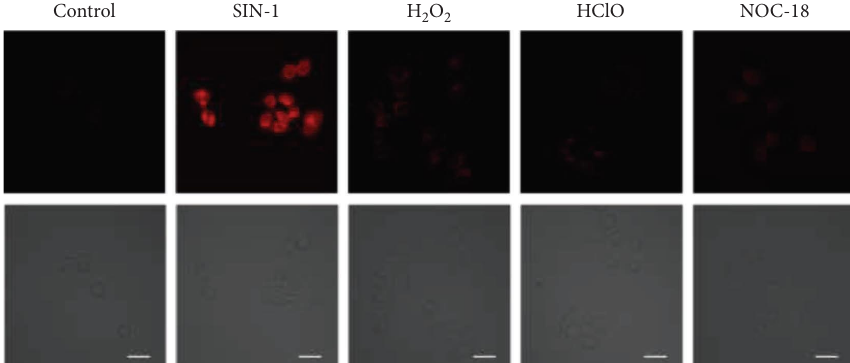
Figure 4: Fluorescent imaging of exogenous ONOO − in RAW 264.7 cells. Te cells were treated with SIN-1, H then, stained with HND-ONOO, respectively. Te scale bar is 20 μ